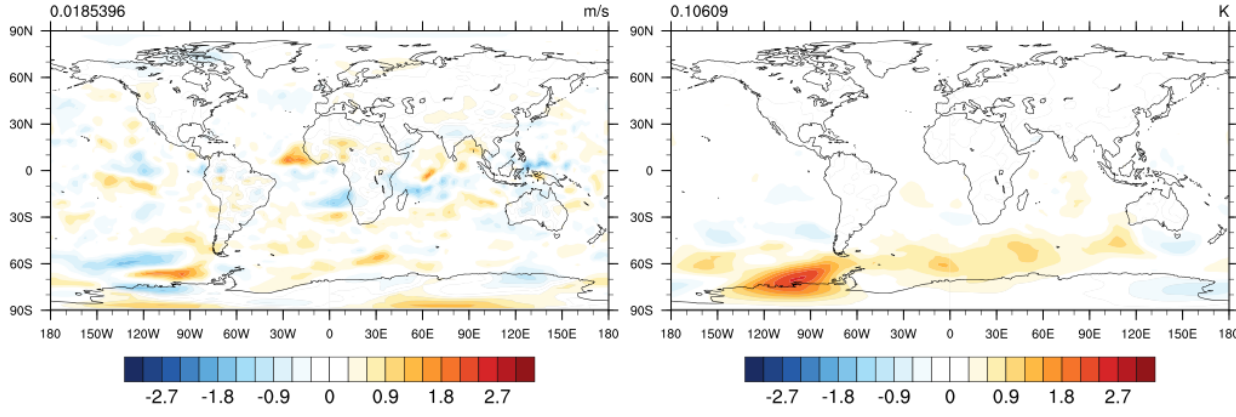
(cid:12) (cid:12) (cid:12) x a sonde − ERA (cid:12) −